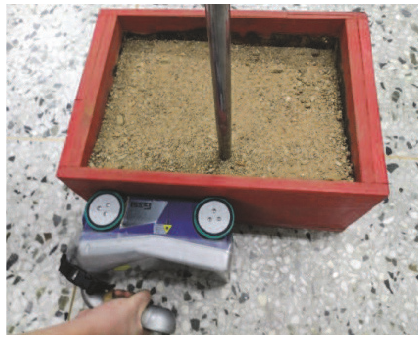
Figure 7: Experiment